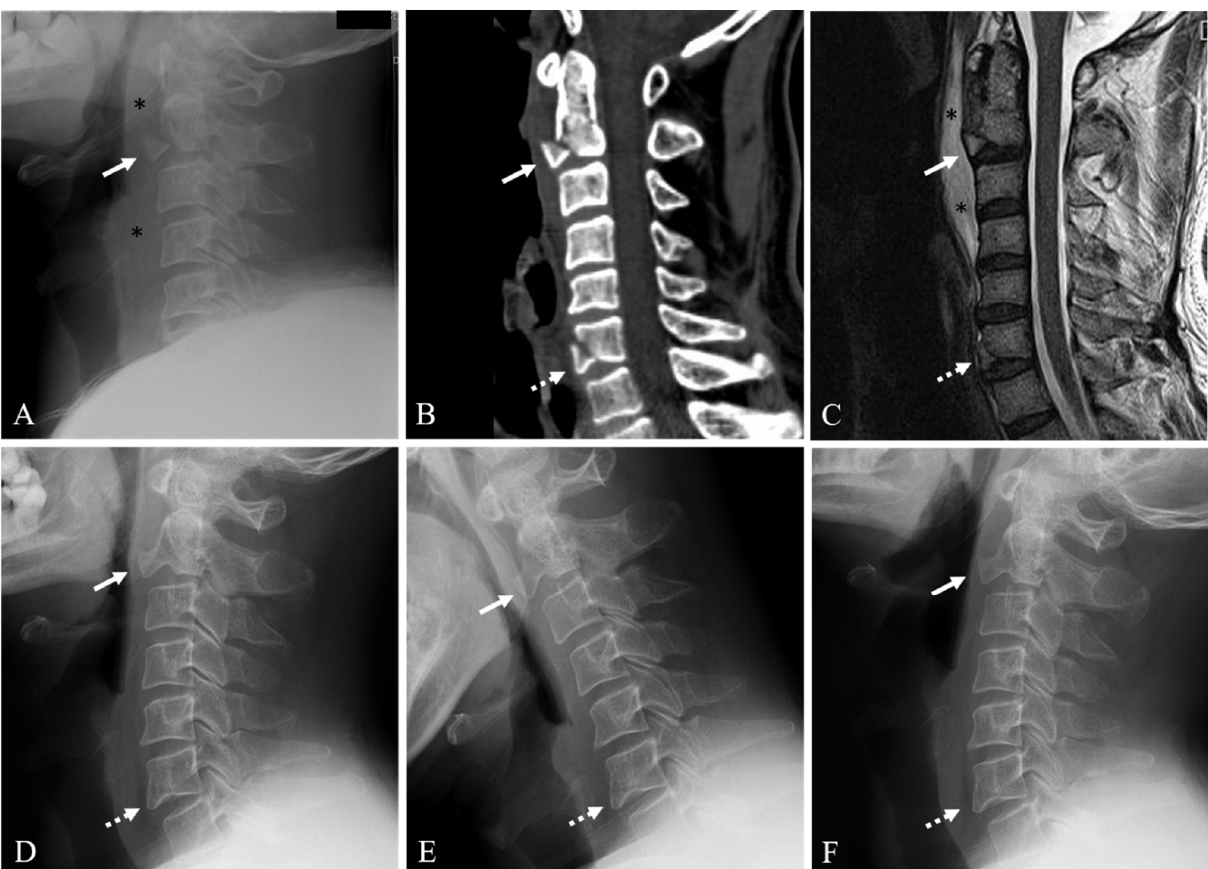
Figure 2. Lateral X-ray ( A ) and sagittal 2-dimensional (2-D) reconstructed computed tomography (CT) scan ( B ) showing anterior C2 tear drop (TD) fracture (white arrow), C6 fracture (dotted white arrow), and prevertebral soft tissue swelling (asterisks). Sagittal magnetic resonance imaging ( C ) showing anterior C2 TD fracture with 38% avulsion fracture ratio (white arrow), C6 fracture (dotted white arrow), and prevertebral hematoma (asterisks). At 12-month follow-up after Philadelphia brace, neutral ( D ), flexion ( E ), and extension ( F ) lateral X-rays showing solid fusion of anterior C2 TD fracture (white arrow) and C6 fracture (dotted white arrow).